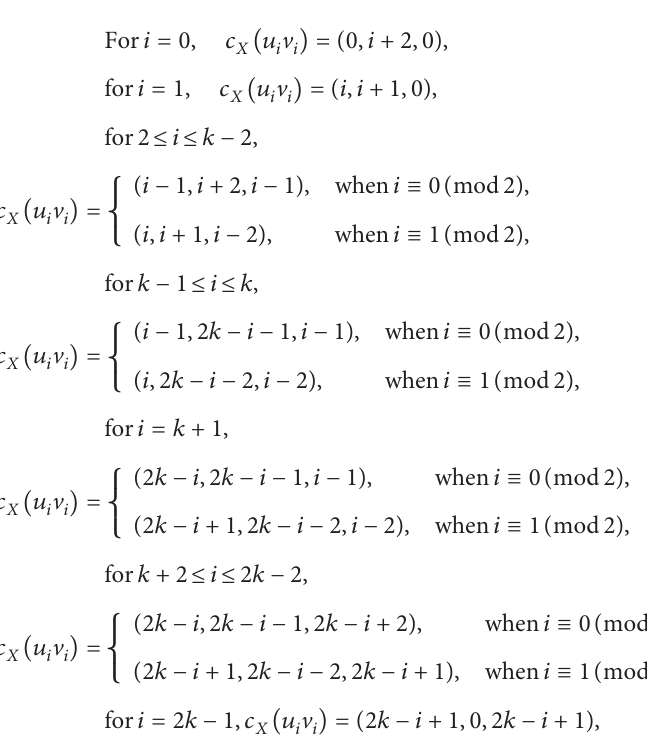
( 1 , 3 , 5 ) for n ≡ 0 ( mod4 ) n